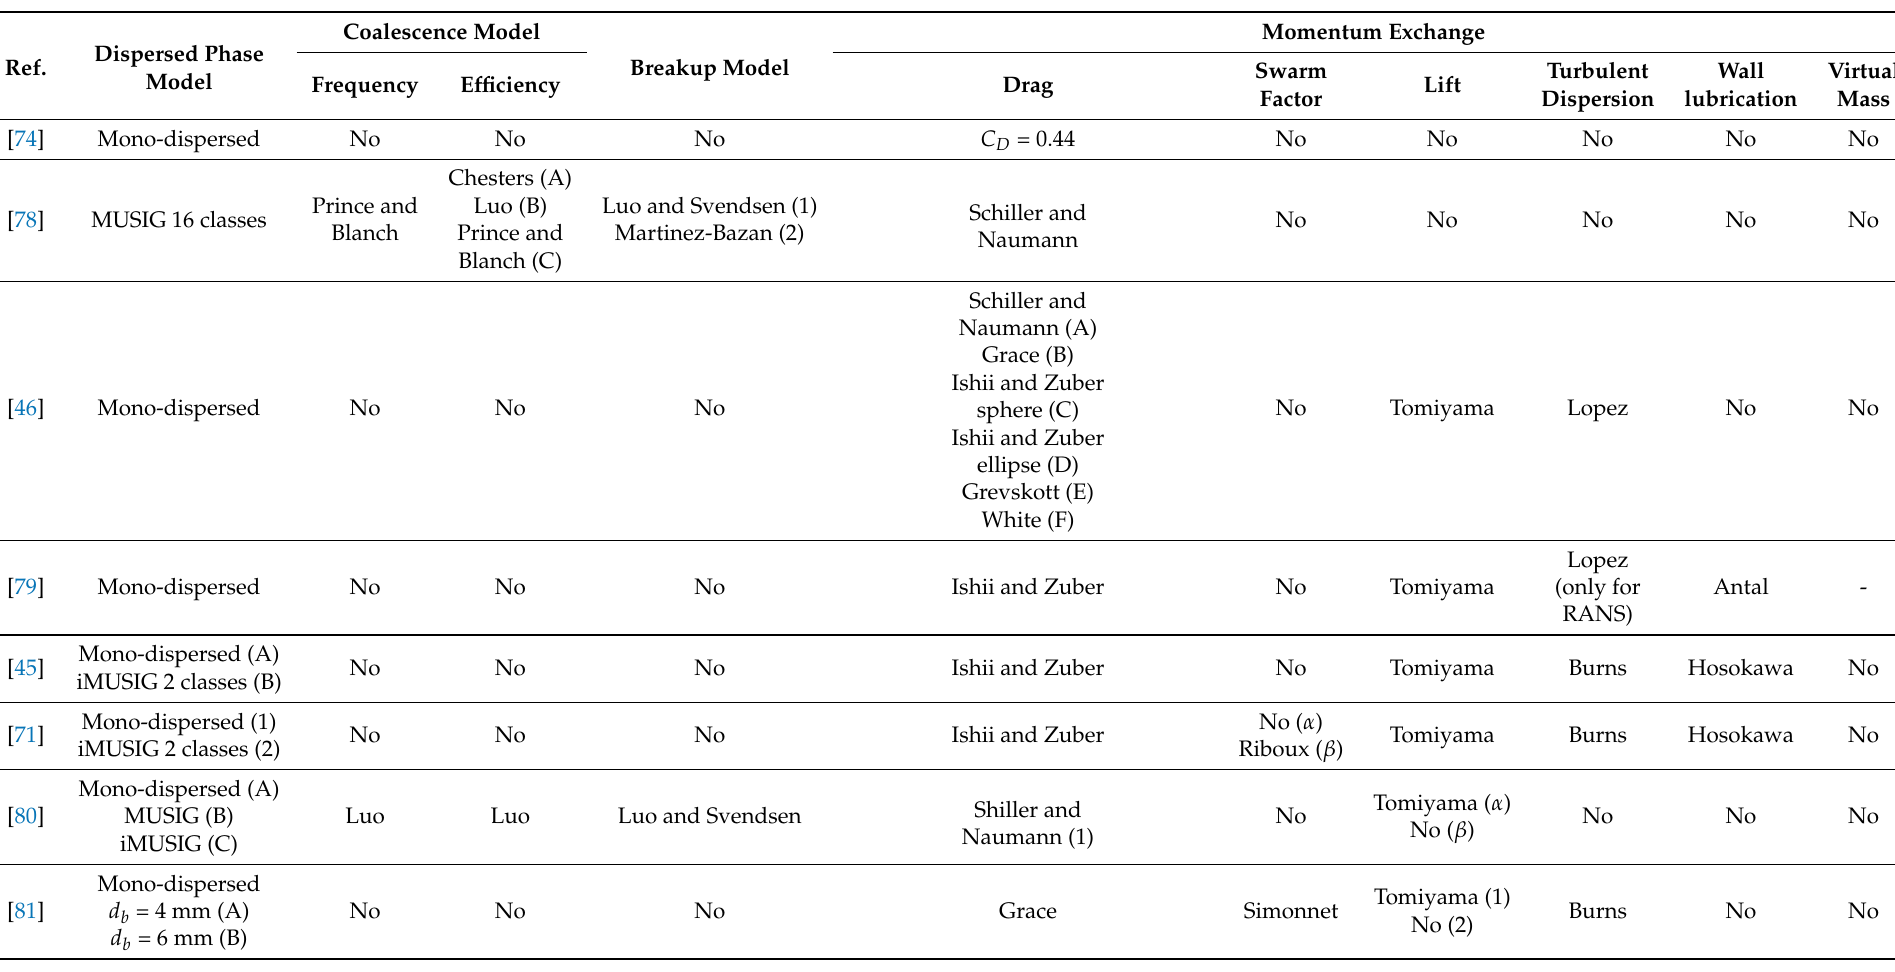
Table 6. Literature survey: model